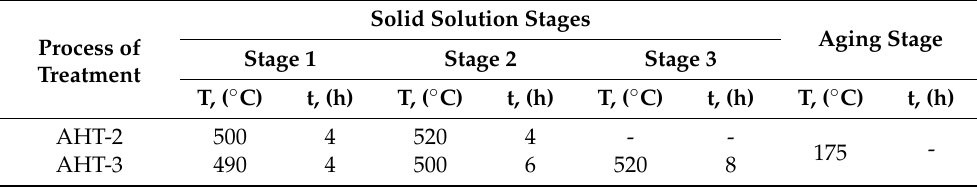
Table 2. Multi-stage solution heat treatment and aging treatment table.